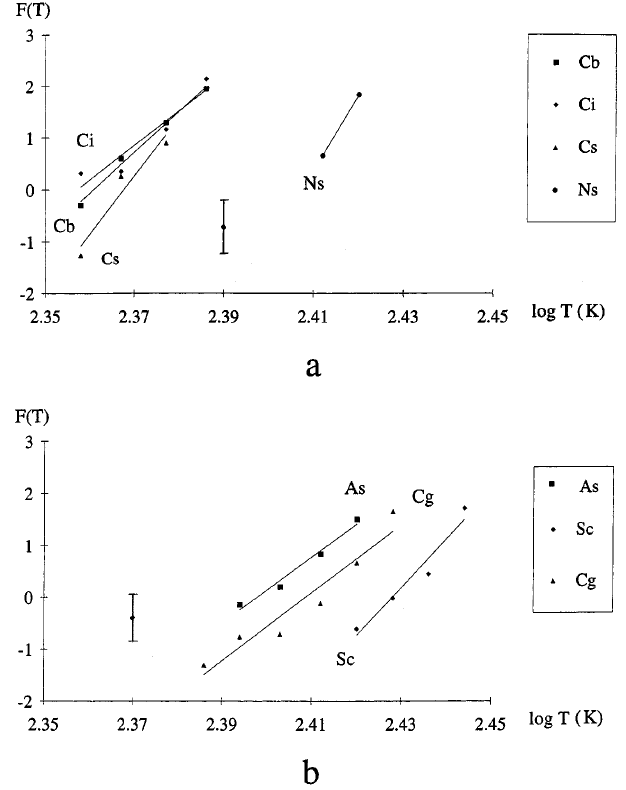
Fig. 4a, b. Cumulative frequency distributions of top temperature ( T , in K) and log-normal fitting: a for types Cb, Ci, Cs, Ns; b for types As, Sc, Cg. The error bar displayed is calculated using Eq. (16) and an accuracy of 2 K on temperatures